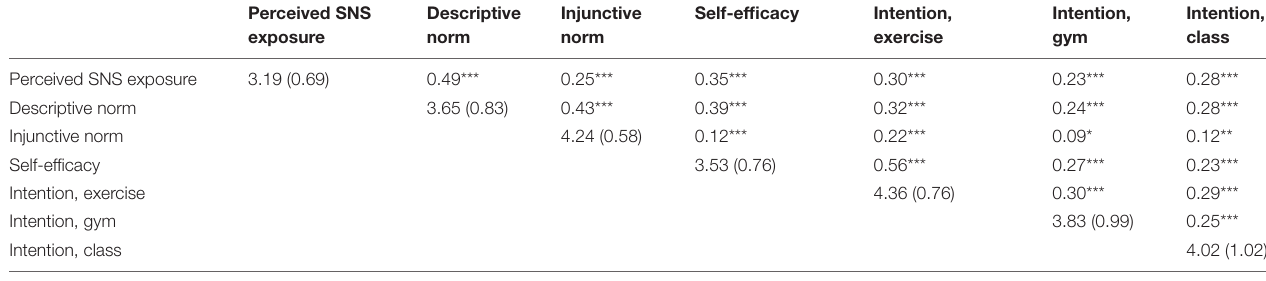
TABLE 1 | Descriptive statistics and zero-order correlations; means (SDs) presented along the diagonal.